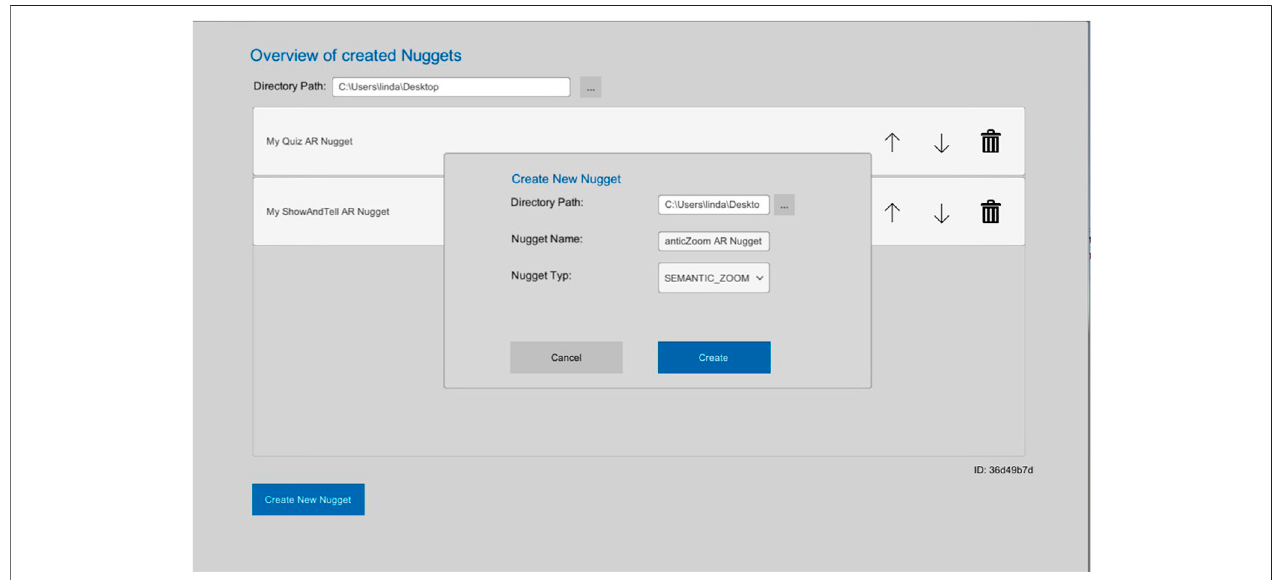
FIGURE2| Screenshotofthe ARNugget authoringtool onthe desktop device. Authorscanadd newARnuggets throughthe drop-down menu and selectan AR nugget to edit from the list.